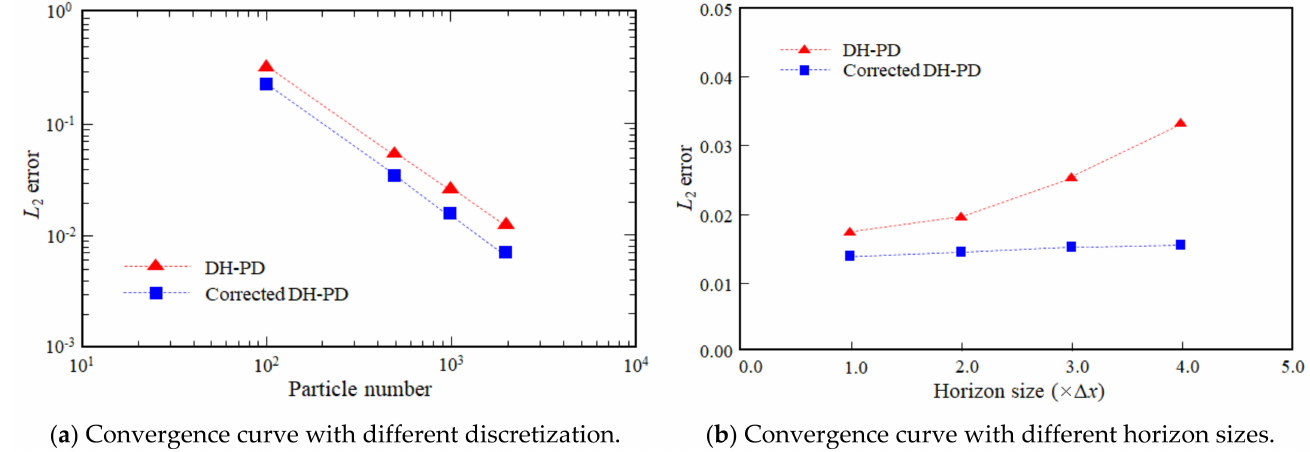
Figure 10. Convergence curves in L 2 error norm of DH-PD and corrected DH-PD models.